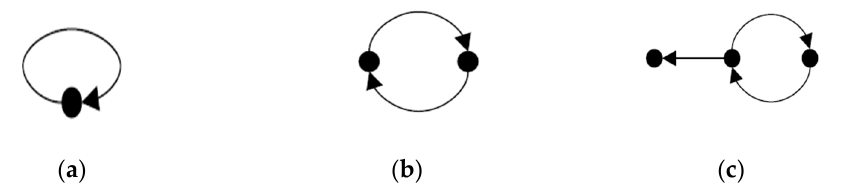
( b ) Figure 6. ( a ) A directed graph; ( b ) Its adjacency matrix. The definition of a graph given by Jain and Krishna is slightly different than Defini- tion 1 [22]. The